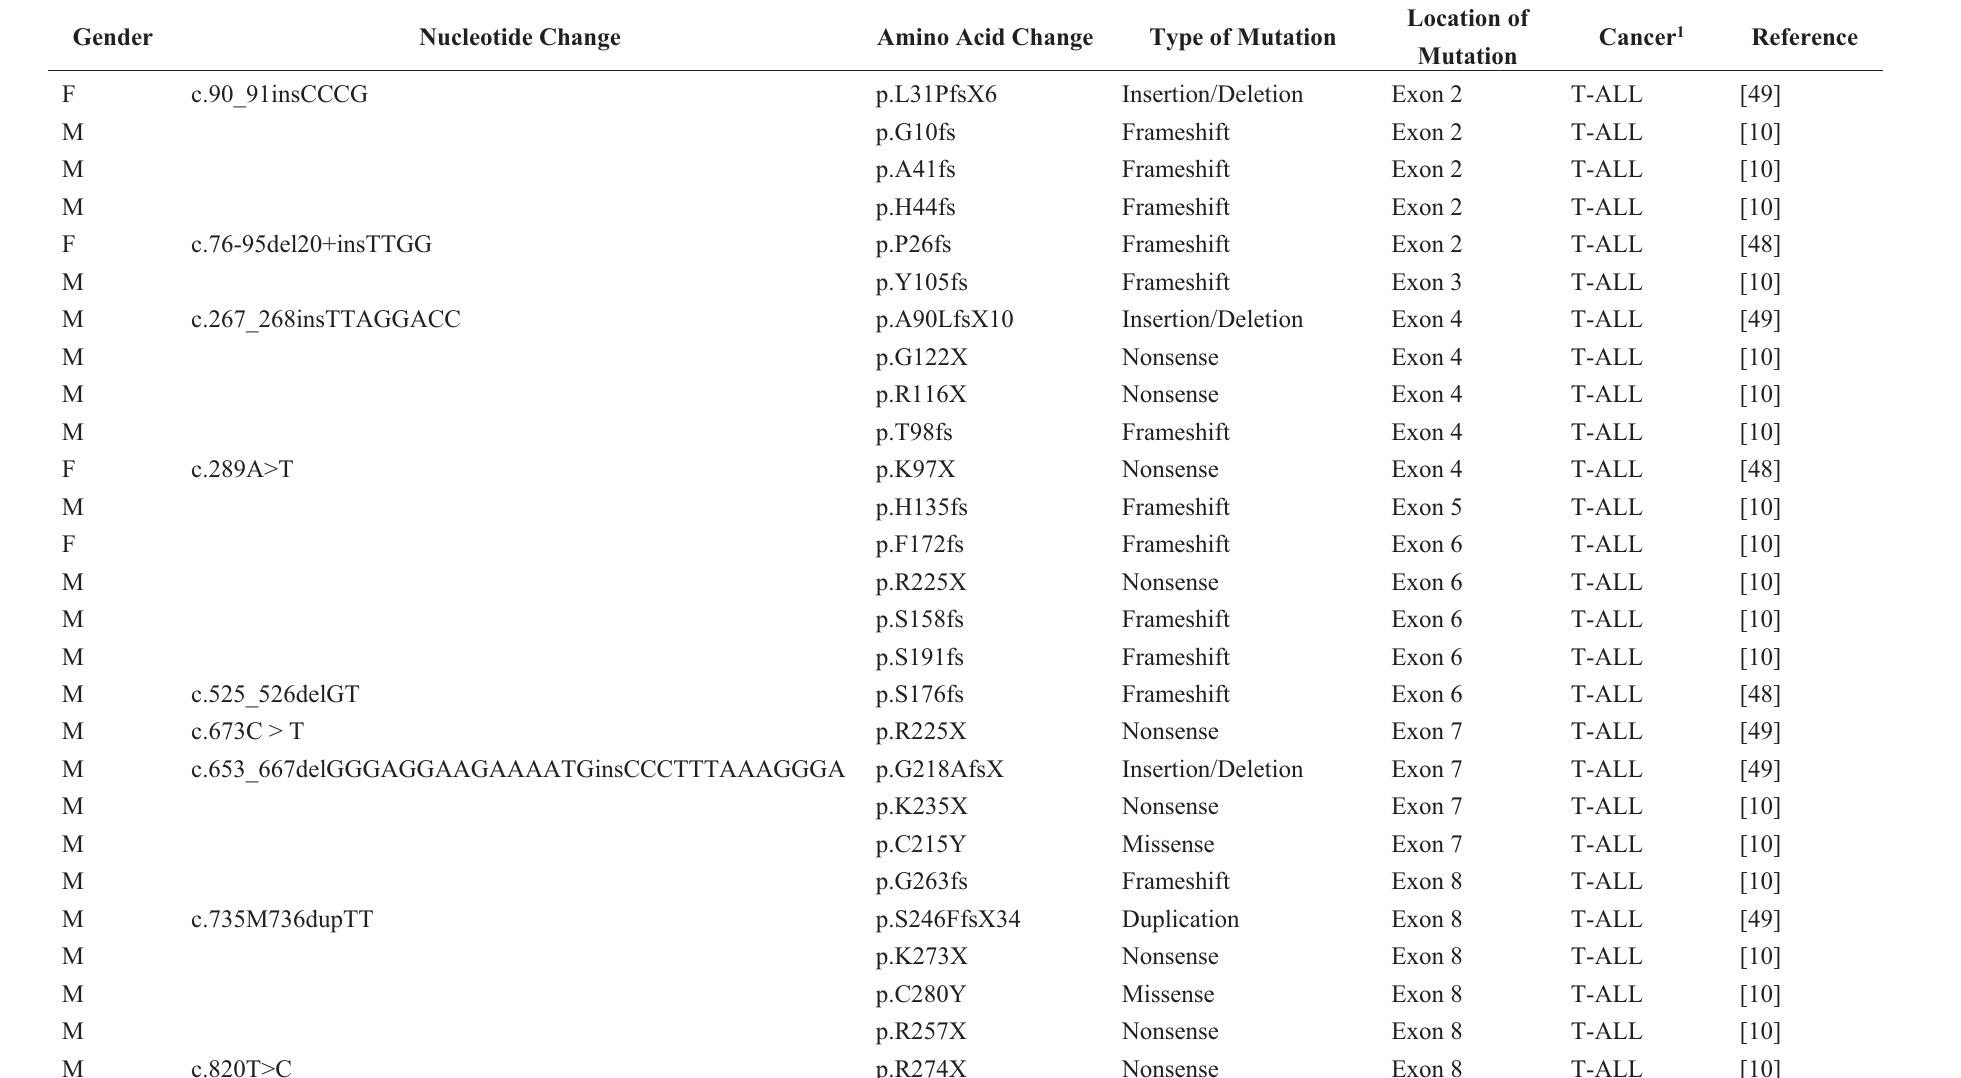
Table 2. Summary of cancer-related PHF6